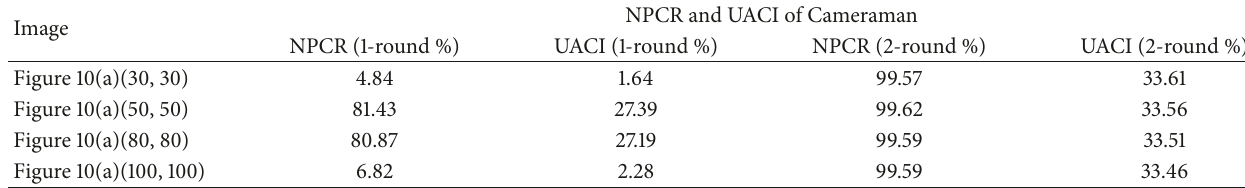
Table 8: NPCR and UACI between cipher-images with slightly different plain-images. Image